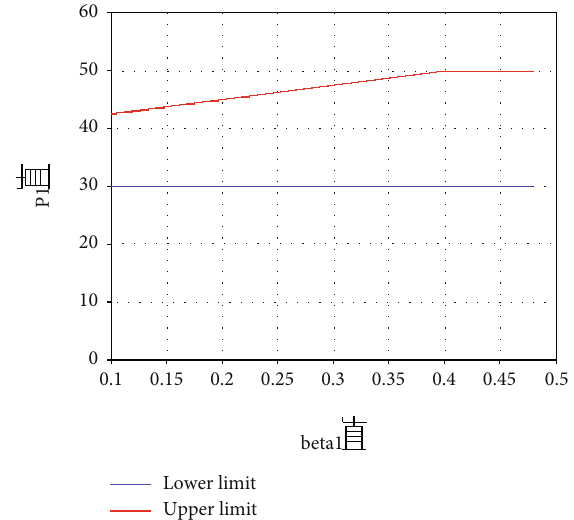
Figure 6: Comparison of psychological pricing and platform